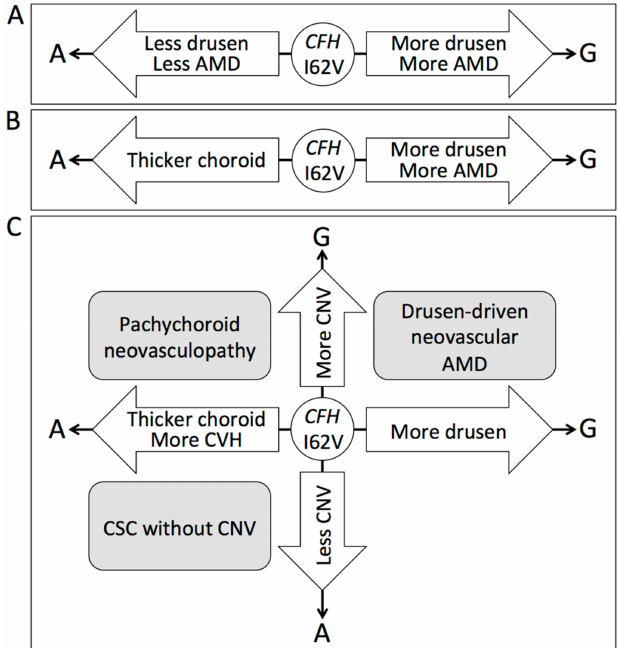
Figure 1. Association of CFH gene polymorphism with age-related macular degeneration (AMD) and pachychoroid. A single nucleotide polymorphism of I62V (rs800292) in CFH has a significant association with the development of AMD. G allele is a risk allele for drusen and AMD, while A allele is a protective allele for drusen and AMD ( A ). I62V in CFH has opposite e ff ects on AMD and pachychoroid. G allele is a risk allele for drusen and AMD but a protective allele for pachychoroid ( B ). I62V in CFH has similar e ff ects to choroidal neovascularization (CNV) development in AMD and pachychoroid diseases. G allele is a risk allele for CNV development both in pachychoroid diseases and drusen-driven AMD ( C